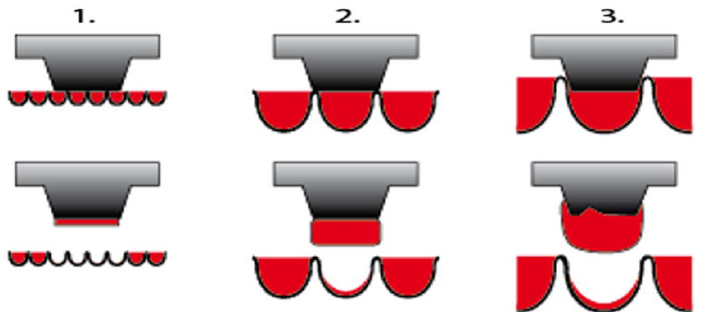
Figure 1. Three specific situations of the relationship between the plate halftone dot and the anilox cell size.